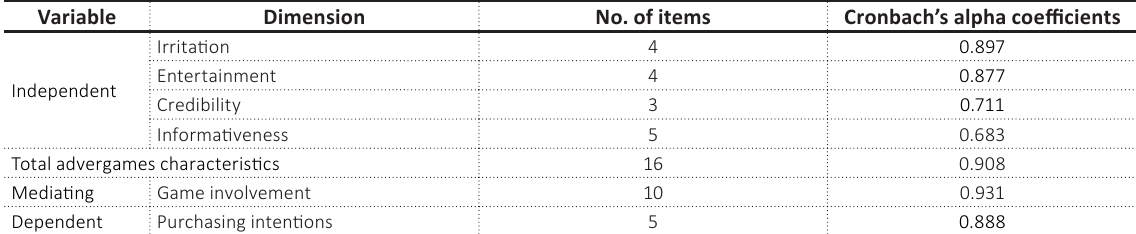
Table 3. Reliability analysis – Cronbach’s Alpha